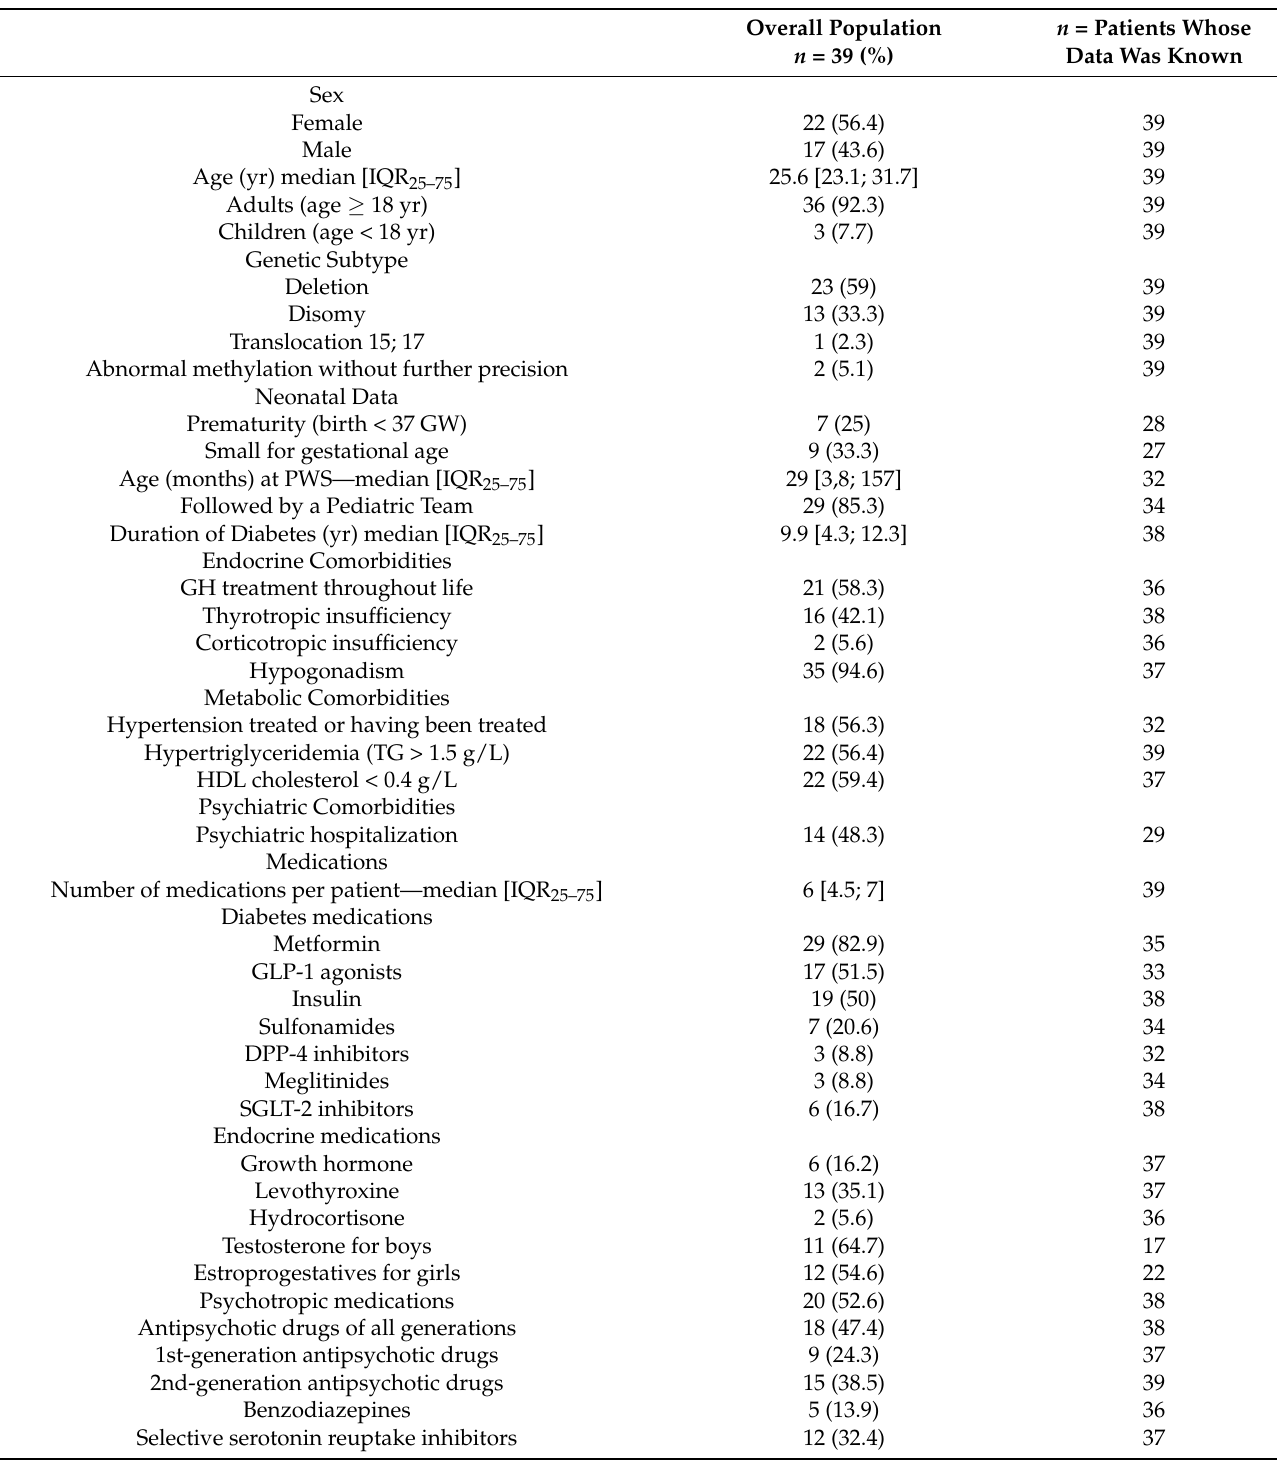
Table 1. Description of the population at inclusion ( n =